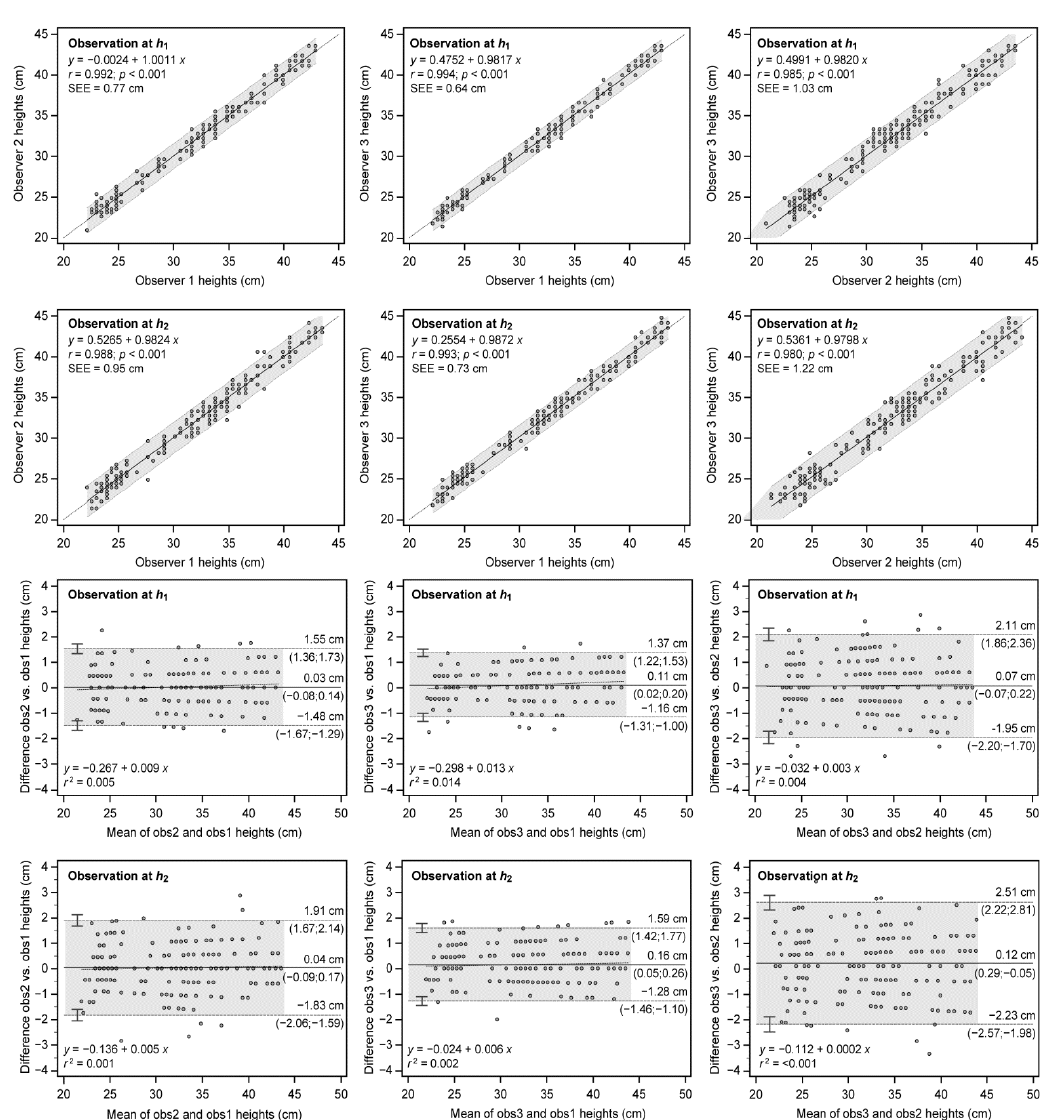
Figure 2. Agreement between observers derived from the two observation heights h 1 and h 2 . Relationship between observations ( top ) and Bland – Altman plots ( down ) are shown. For regression, the dotted line represents linear regression; upper and lower dashed lines show 95% confidence intervals. Predictive linear regression equations, Pearson’s product-moment correlation coefficient ( r ) and standard error of estimate (SEE) are also depicted. For Bland–Altman, the solid central line represents the mean between observations (systematic bias); upper and lower dashed lines show mean ± 1.96 SD (random error) with CI-95% limits in parentheses; the dotted line depicts linear regression (proportional bias). Linear regression equations of the differences and determination coefficient r 2 are also shown to inspect bias